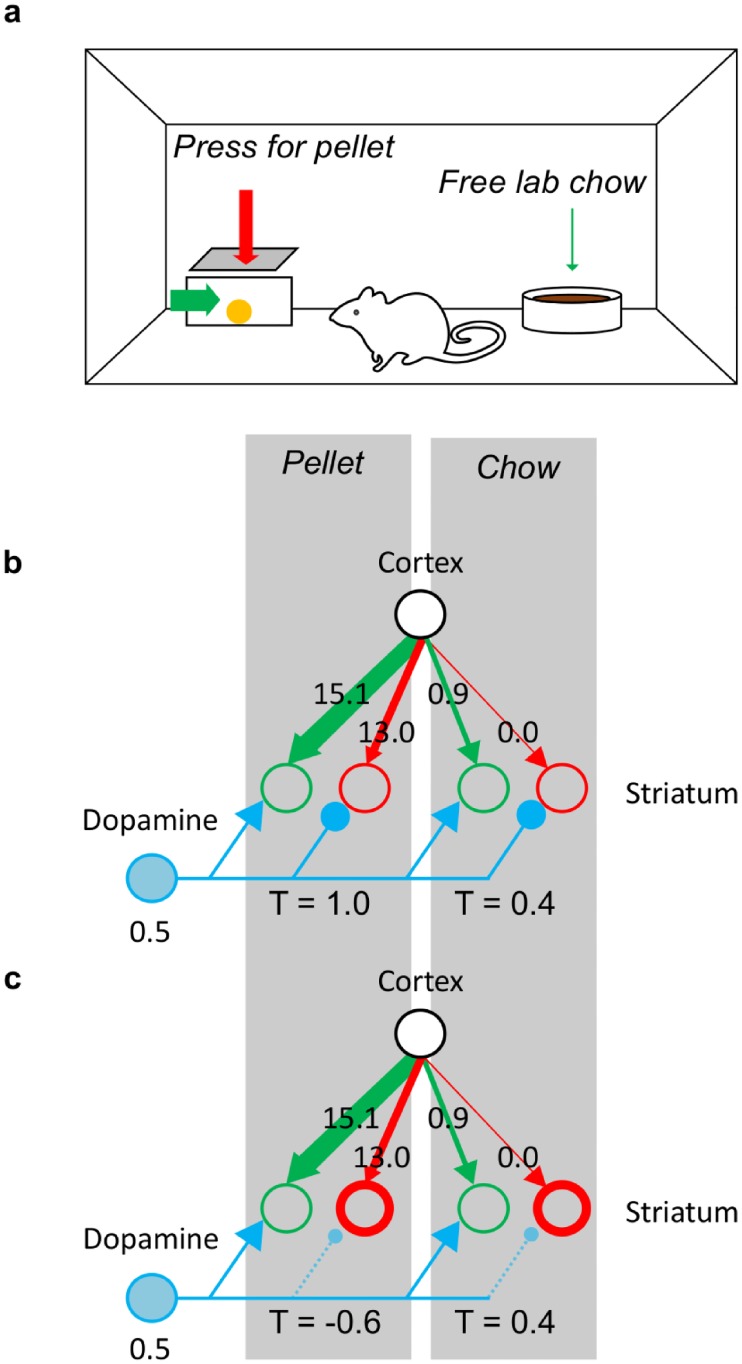
Effects of D2 blocking on the willingness to exert effort.(a) Schematic illustration of the experimental setup. (b) Action selection in control state. Green and red circles on the left denote striatal Go and No-Go neurons associated with pressing the lever, while the green and red circles on the right denote the neurons associated with approaching the free food. The strengths of the synaptic connections, which result from simulated learning, are indicated by the thickness of the arrows, and the labels. The parameters used for the simulations were obtained through a fit of the model to the experimental data. The blue circle represents a population of dopaminergic neurons, and its shading indicates the level of activity. (c) Action selection in the dopamine-depleted state. The notation is the same as in panel (b), with the thick red circles indicating enhanced activity in the No-Go population, which results from blocked dopaminergic inhibition (symbolised by the smaller inhibitory projections of the dopamine neurons).